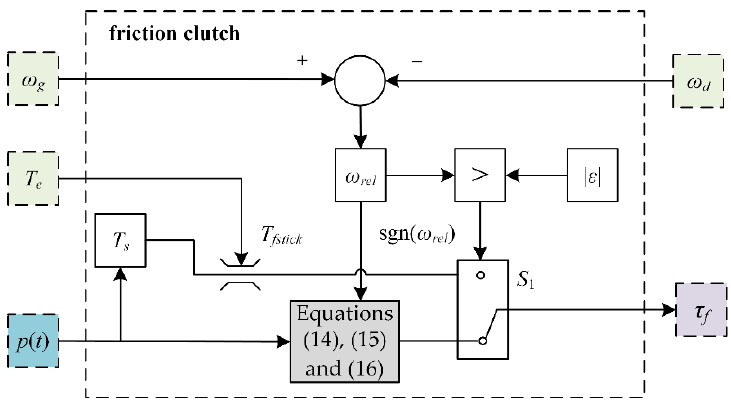
Figure 7. Block diagram of the Karnopp model for hydraulic friction clutches.